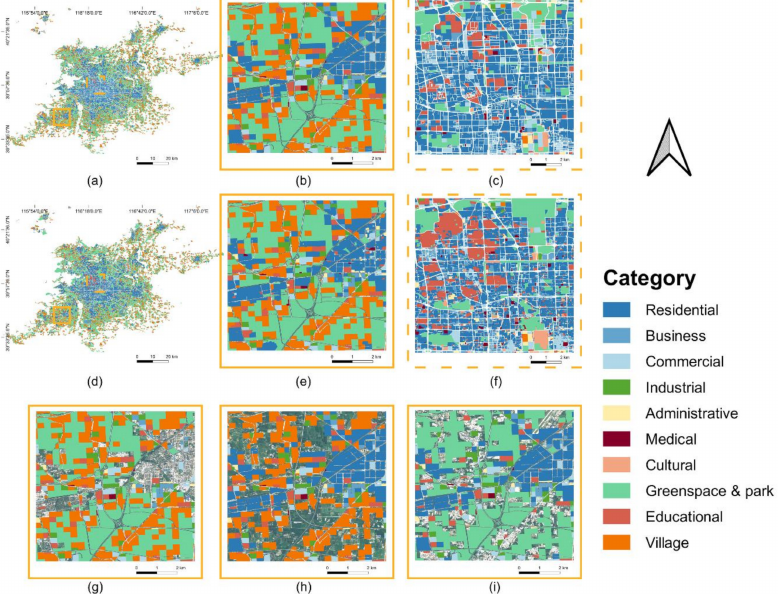
Figure 17. Comparison and zoomed-in views of EULUC-AOI (OSM+300 m grid) in Beijing, 2019. ( a ) The mapping results before overlaying the AOIs layers; ( b , c ) zoomed-in views of ( a ); ( d ) the mapping results after overlaying the AOIs layers; ( e , f ) zoomed-in views of ( d ); the zoomed-in views with solid lines outside shows details in the solid box in the lower-left corner of the mapping results. The zoomed-in view with dashed lines outside shows details in the dashed box near the middle of the mapping results. ( g – i ) The results of ( b ) with the removal of residential, greenspace, and village units in turn, with Sentinel II optical images in the background.